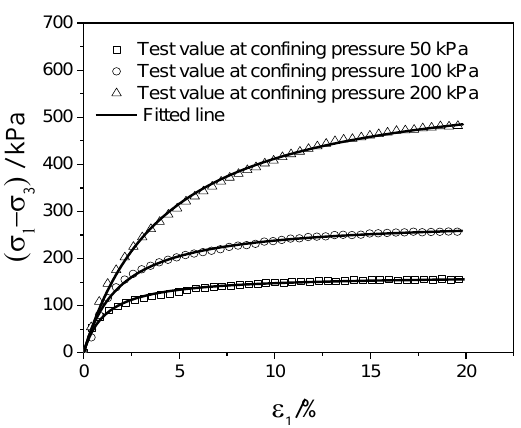
Figure 12. Constitutive analysis for the remolded W-OH Pisha sandstone composited with the W-OH concentration of 4%.